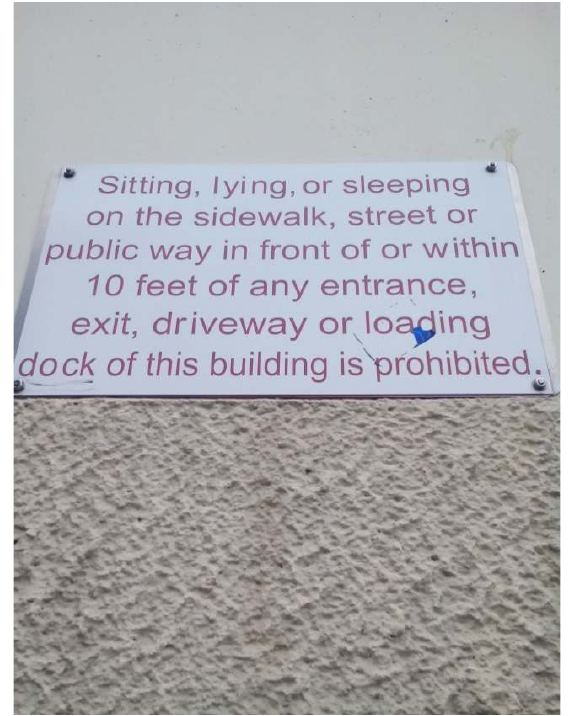
Figure 2. Public bans. Skid Row. Los Angeles. June